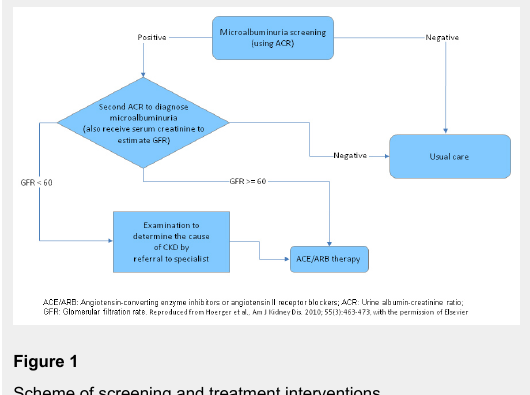
Scheme of screening and treatment interventions. ACE/ARB: Angiotensin-converting enzyme inhibitors or angiotensin II receptor blockers; ACR: Urine albumin-creatinine ratio; GFR: Glomerular filtration rate. The same screening and treatment scheme does apply for patients with macroalbuminuria. Such patients will also be detected in a microalbuminuria screening. Modified and reproduced from Hoerger TJ, Wittenborn JS, Segel JE, Burrows NR, Imai K, Eggers P, et al.Am J Kidney Dis. 2010:55(3):463–73, with the permission of Elsevier.